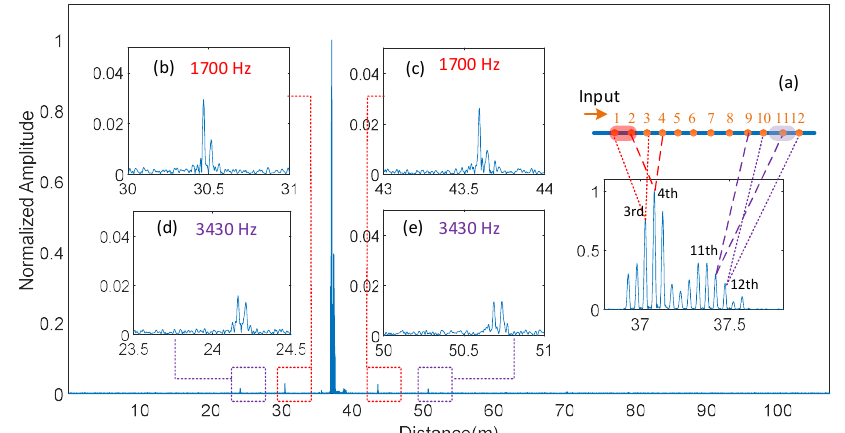
Figure 5. Time-domain signal when the PCCs located at 37.05 m and 37.47 m were driven at 1700 Hz and 3430 Hz. Insets: Expanded time signal. ( a ) The main lobes formed by the reflector array; ( b , c ) sidelobes generated by the PCC1 centered at 37.43 m and driven at 1700 Hz; ( d , e ) sidelobes caused by the vibration of PCC2 located at 37.08 m and driven at 3430 Hz.